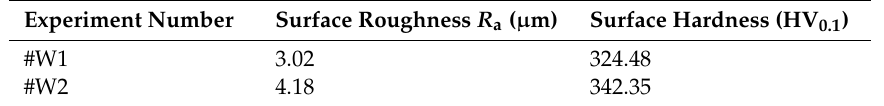
Figure 3. Photographs of the wheel / rail samples after machining: ( a ) wheel samples after turning; ( b ) rail samples after grinding. Table 4. Surface roughness and hardness of the machined wheel / rail